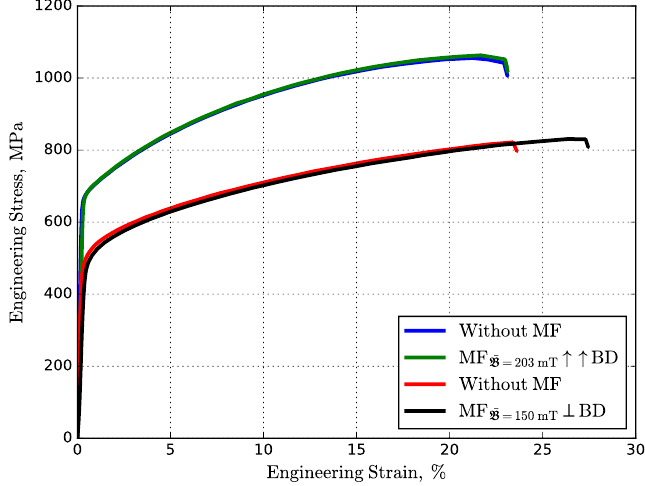
Figure 12. Typical engineering stress–strain curves of fabricated Inconel 718 samples obtained at different mutual orientations between the MF and build direction. (The blue/green and red/black lines correspond to the printed horizontal and vertical